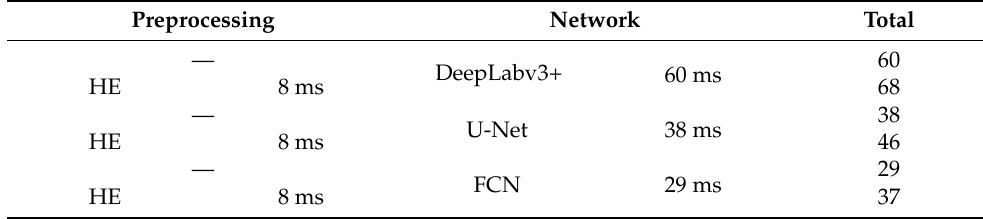
Table 9. Run time of the classifiers.